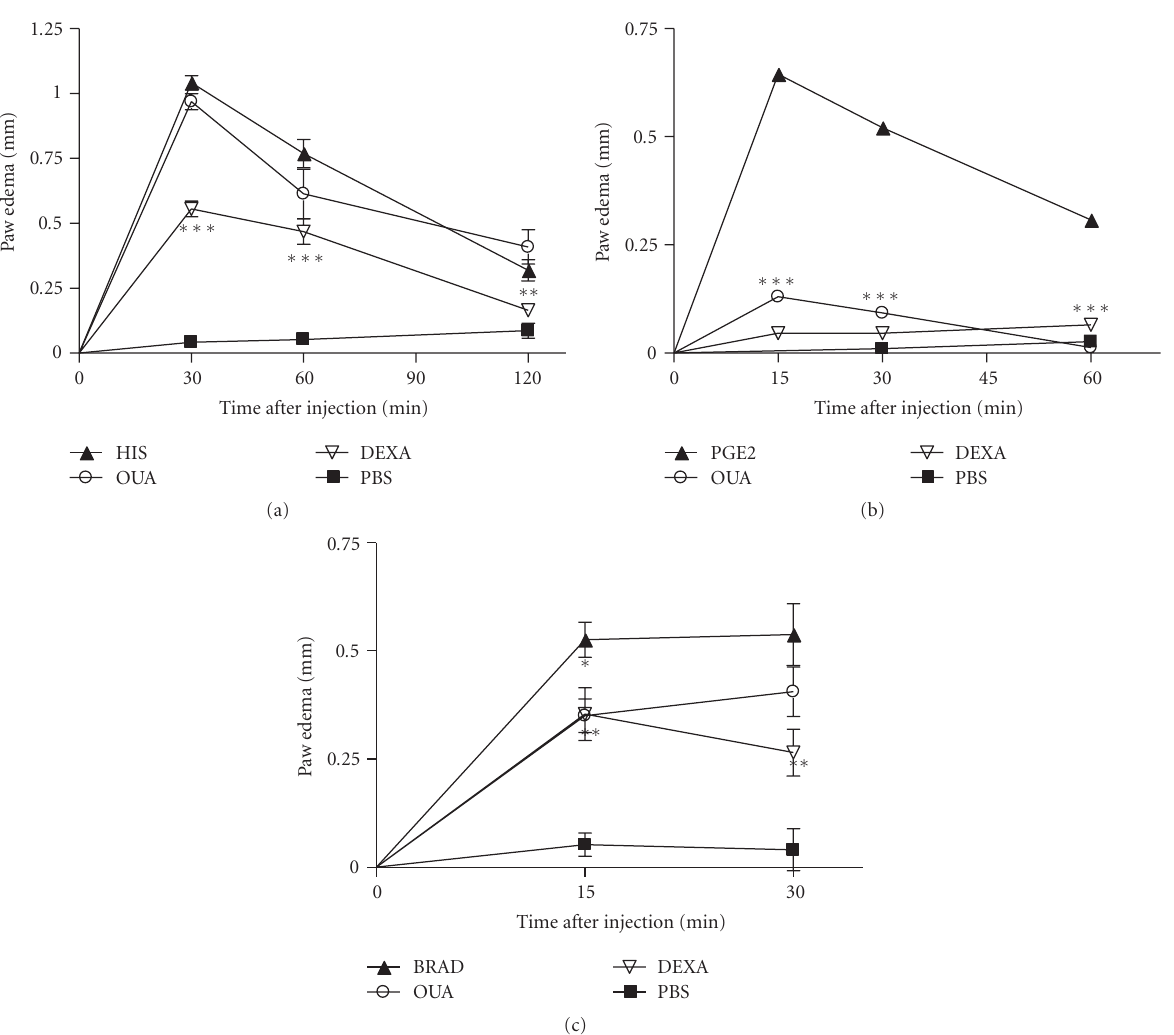
Figure 3: E ff ect of the pretreatment with Ouabain (OUA, 0.56mg/kg) administered intraperitoneally on paw edema triggered by histamine (HIS), prostaglandin E2 (PGE2) and bradykinin (BRAD). Mice received intraplantar injections of histamine(100 μ g/paw, (a)),prostaglandin E2 (5 μ g/paw, (b)) or bradykinin (6nmol/paw, (c)) in 20 μ L of phosphate bu ff ered saline (PBS) in the right hindpaw and 20 μ L of PBS in the left hindpaw. Each point represents the mean of eight animals. Dexametasone (0.5mg/kg) was used as antiinflammatory control and injected i.p. one hour before intraplantar challenge. Data were expressed as mean ± S.E.M. and analyzed by software Graphpad Prism using Student’s t -test followed by unpaired test ∗ P < . 05, ∗∗ P < . 01, and ∗∗∗ P < . 001.